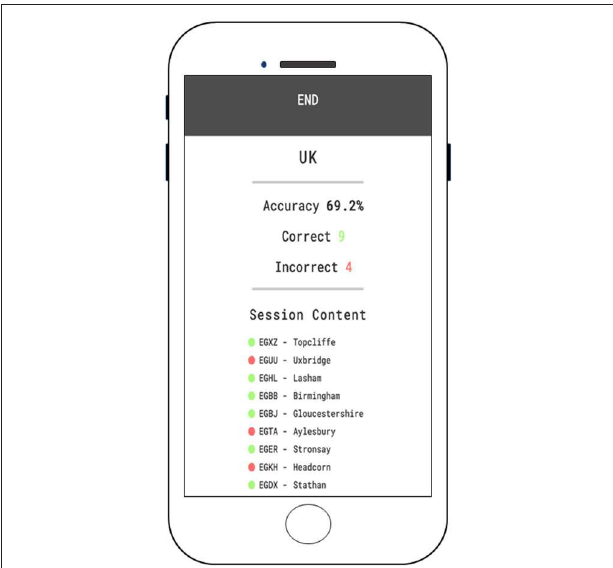
FIGURE 6 | Results screen of Location Indicators.